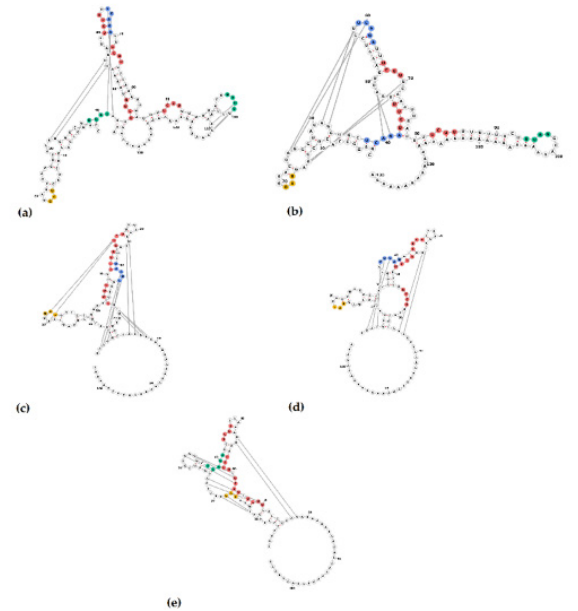
Figure 7. Secondary structure of 3 ′ UTR of PoAstV3 and RNA binding sites for serine/arginine-rich splicing factor 5 (SRSF5 [UCAGA, green bases]), heterogeneous nuclear ribonucleoprotein E2 (hnRNPE2 [UUAG/UUAU, blue bases]) and polypyrimidine tract-binding protein (PTB [UCUU, red bases]). USA consensus sequence ( a ), strain ESP/B333/2017 ( b ), Hungarian consensus sequence ( c ), GER/L00919-K17/2014 ( d ) and JPN/Bu2-5/2014 ( e ). UAG stop codon (amber bases).